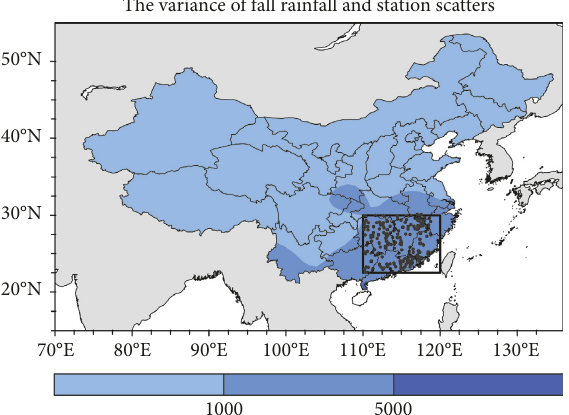
Figure 1: The shadings represent the variance of rainfall average, the rectangle denotes the SEC, and the black dots denote the 74 stations in SEC.